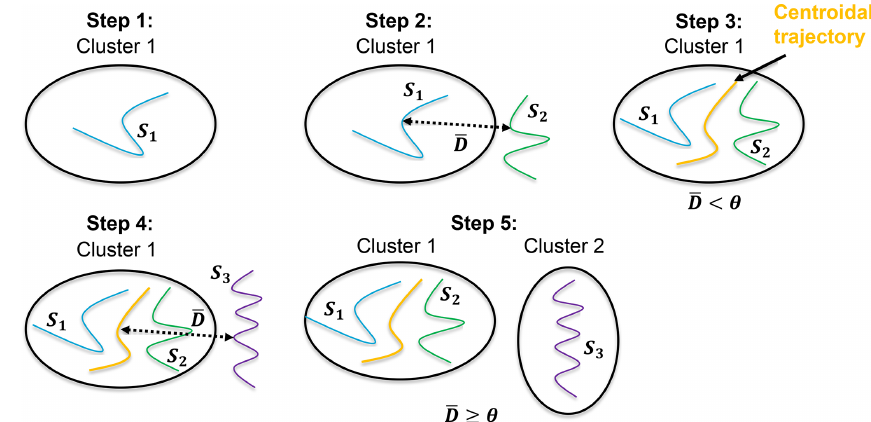
Figure 3. Illustration of the five steps of the QuickBundles clustering algorithm. Air parcel trajectories are denoted by S 1 through S 3 , θ is the user-defined clustering threshold and D is the mean element-wise distance between trajectories according to Eq. (1) (for details, see text).